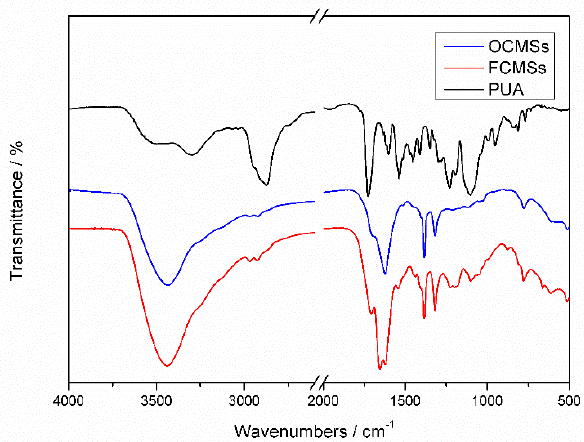
Figure 2. The FTIR spectra of polyurethane acrylates (PUA), organic carbon microspheres (OCMSs) and FCMSs.